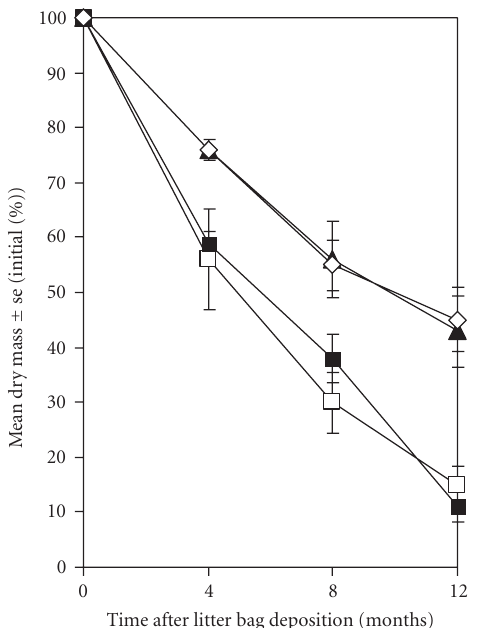
Figure 9: Decreasing mass of birch leaf litter from 3mm mesh litter bags related to tree plots on the Isle of Rum; from known earthworm communities below pure stands of oak- (cid:2) ; birch- (cid:3) ; pine- (cid:5) ; on moorland- ♦ (adapted from [9]).